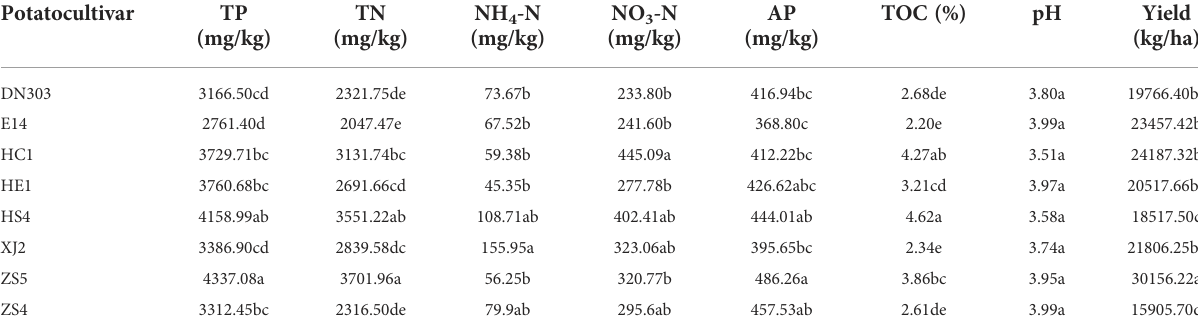
TABLE 1 Soil properties and potato